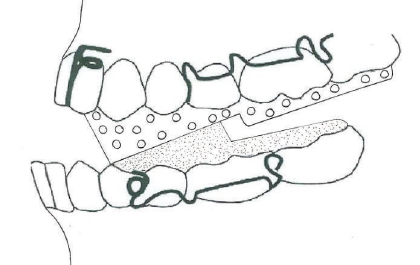
Figure 3: Double-plate